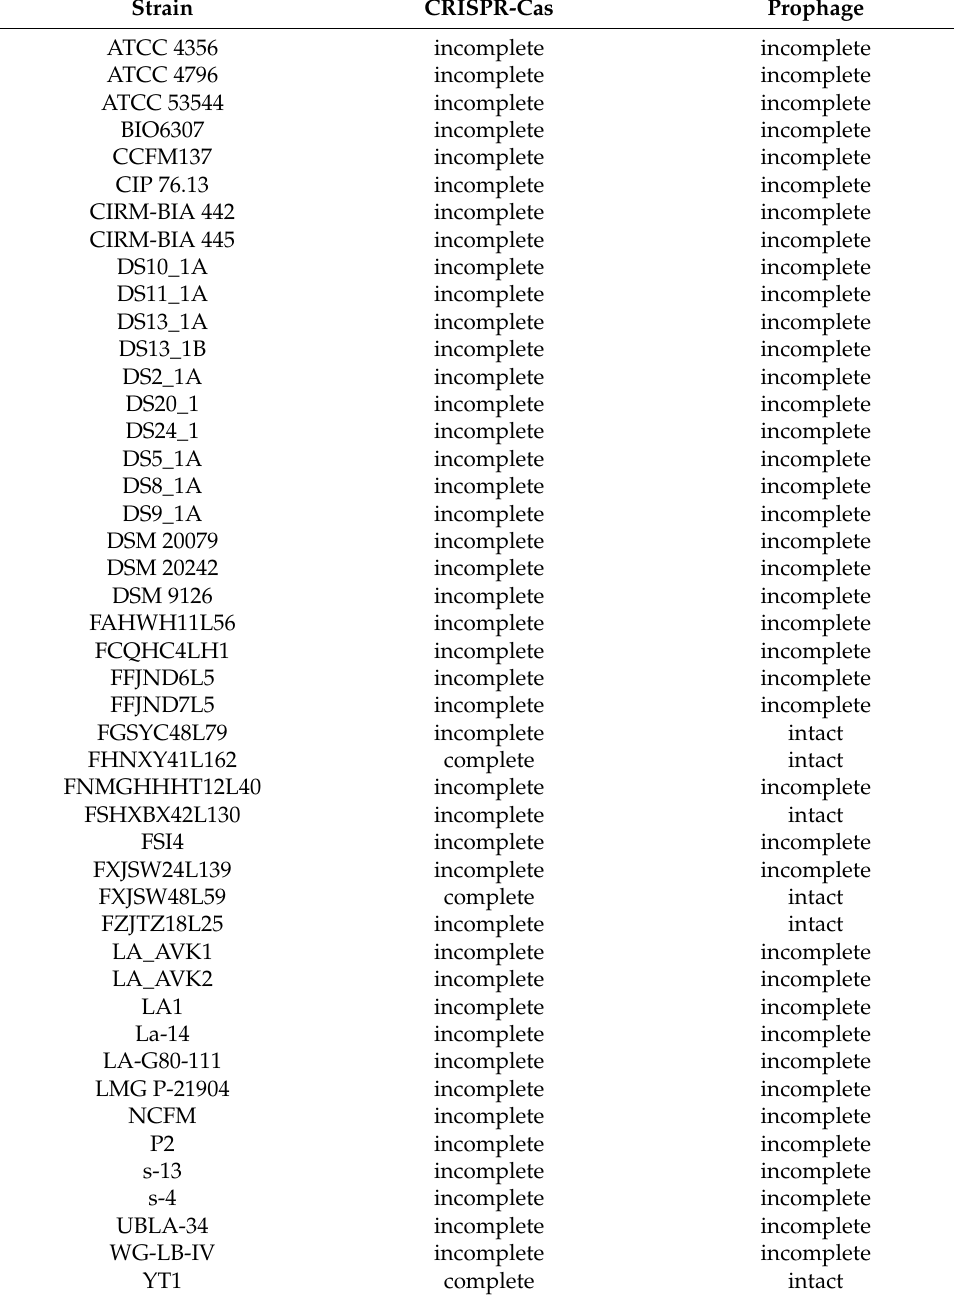
Table 3. CRISPR-Cas systems and prophages in L. acidophilus